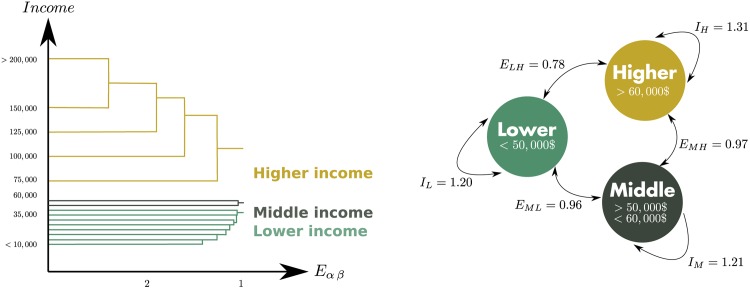
(Left) Alluvial diagram showing the successive aggregation of different income categories during the clustering process. The x-axis shows the value of the exposure at which each aggregation took place. The aggregation stops when there is no pair of category (α, β) for which Eαβ > 1, that is when all classes are at best indifferent to one another (see S1 Text, section 2 for a more detailed description of the algorithm). One can see on this diagram that the highest income categories tend to colocate more (higher values of Eαβ) than the lowest income categories. (Right) The 3 classes that emerge from the clustering process. In the circles we indicate the range of income to which each class corresponds. The value next to the arrows correspond to the respective values of exposure and isolation. As the values of exposure show, the lower- and higher-income classes repel one another, while the middle-income class is indifferent to the other classes. Furthermore, the higher-income class is a more coherent group than the middle-income and lower-income classes, as reflected by the values of the isolation coefficient I.